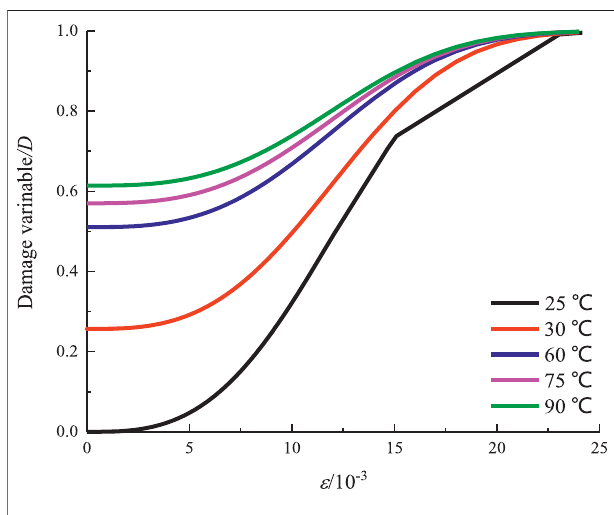
FIGURE 13 | thermal-mechanical coupling sandstone